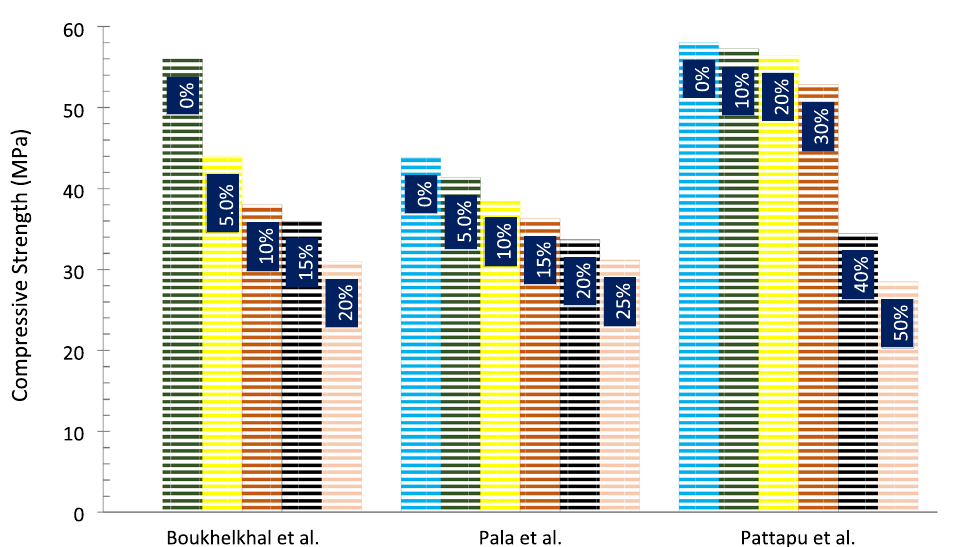
Fig. 8 Compressive strength (Boukhelkhal et al., 2017; Pala et al., 2015; Pattapu & Lal